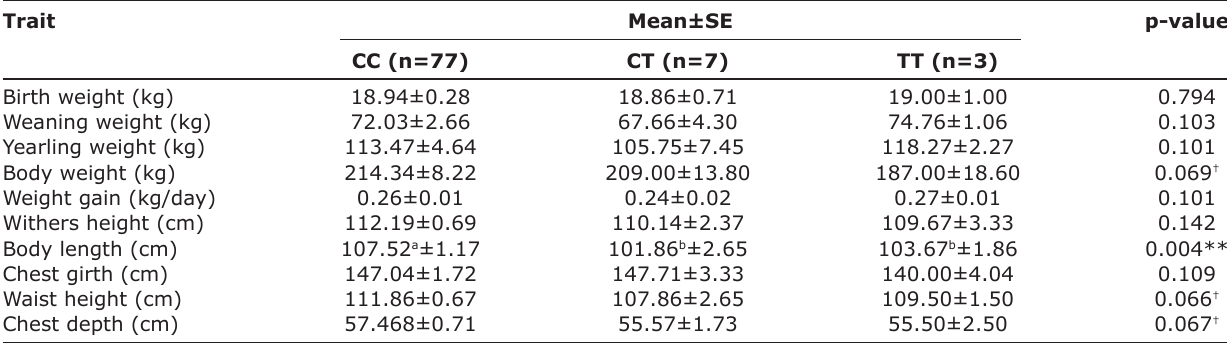
Table-3: Association between the g.48308 C>T single-nucleotide polymorphism of pleomorphic adenoma gene 1 and body weight and traits in Bali cattle.